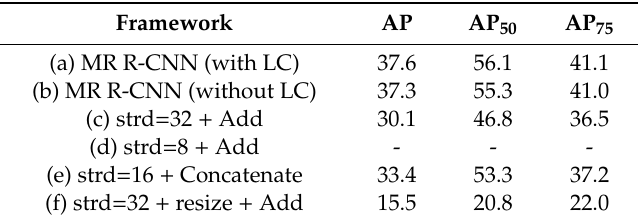
Table 5. Results of six di ff erent designs of the refinement